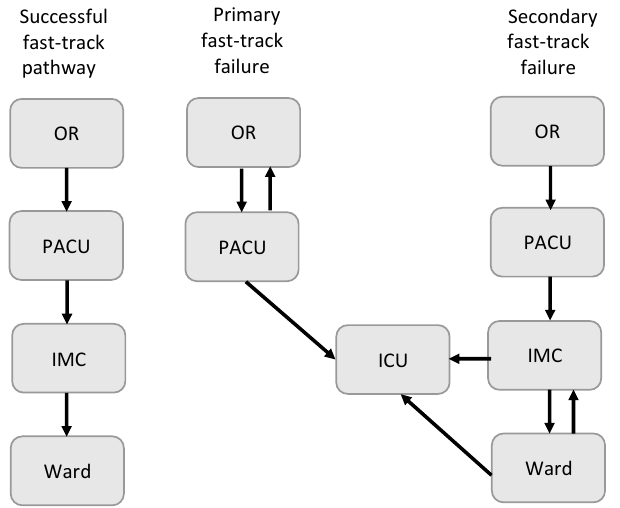
Figure 1. Types of fast-track failure. OR = operating room; PACU = postanesthetic care unit, IMC = intermediate care unit, ICU = intensive care unit.